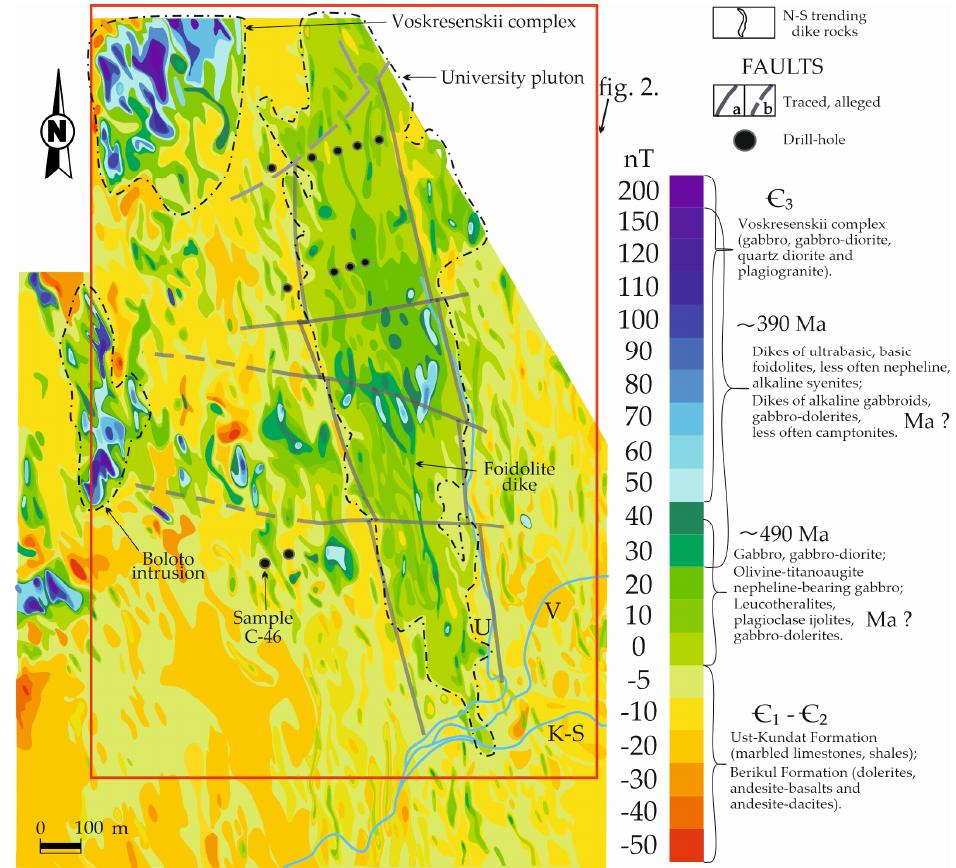
Figure 4. Magnetic map of the University pluton at a scale of 1:5000 based on ground survey by [56] with processing by the authors. K-S = Kiiskii-Shaltyr river; V = Voskresenka stream; U = University stream. Same area as in Figure 2. The center of the image is at about N55°05′30″, E88°23′30″. Red box locates Figure 2.